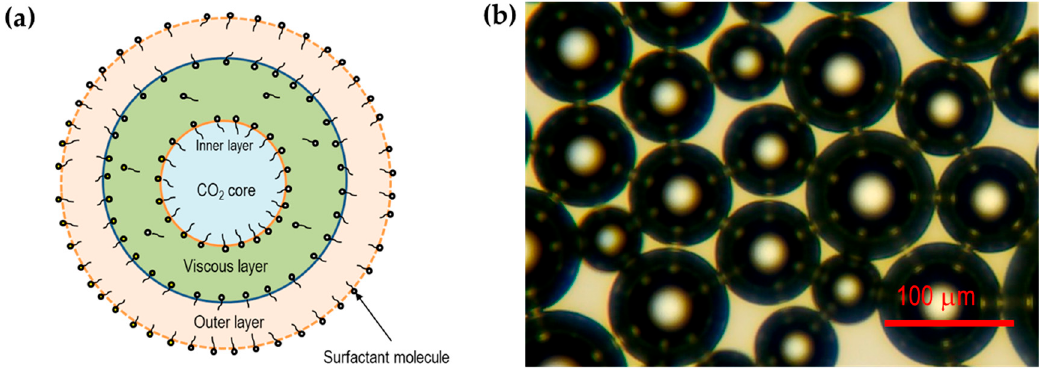
Figure 1. ( a ) CO 2 microbubbles structure and ( b ) microscopic image in this study.